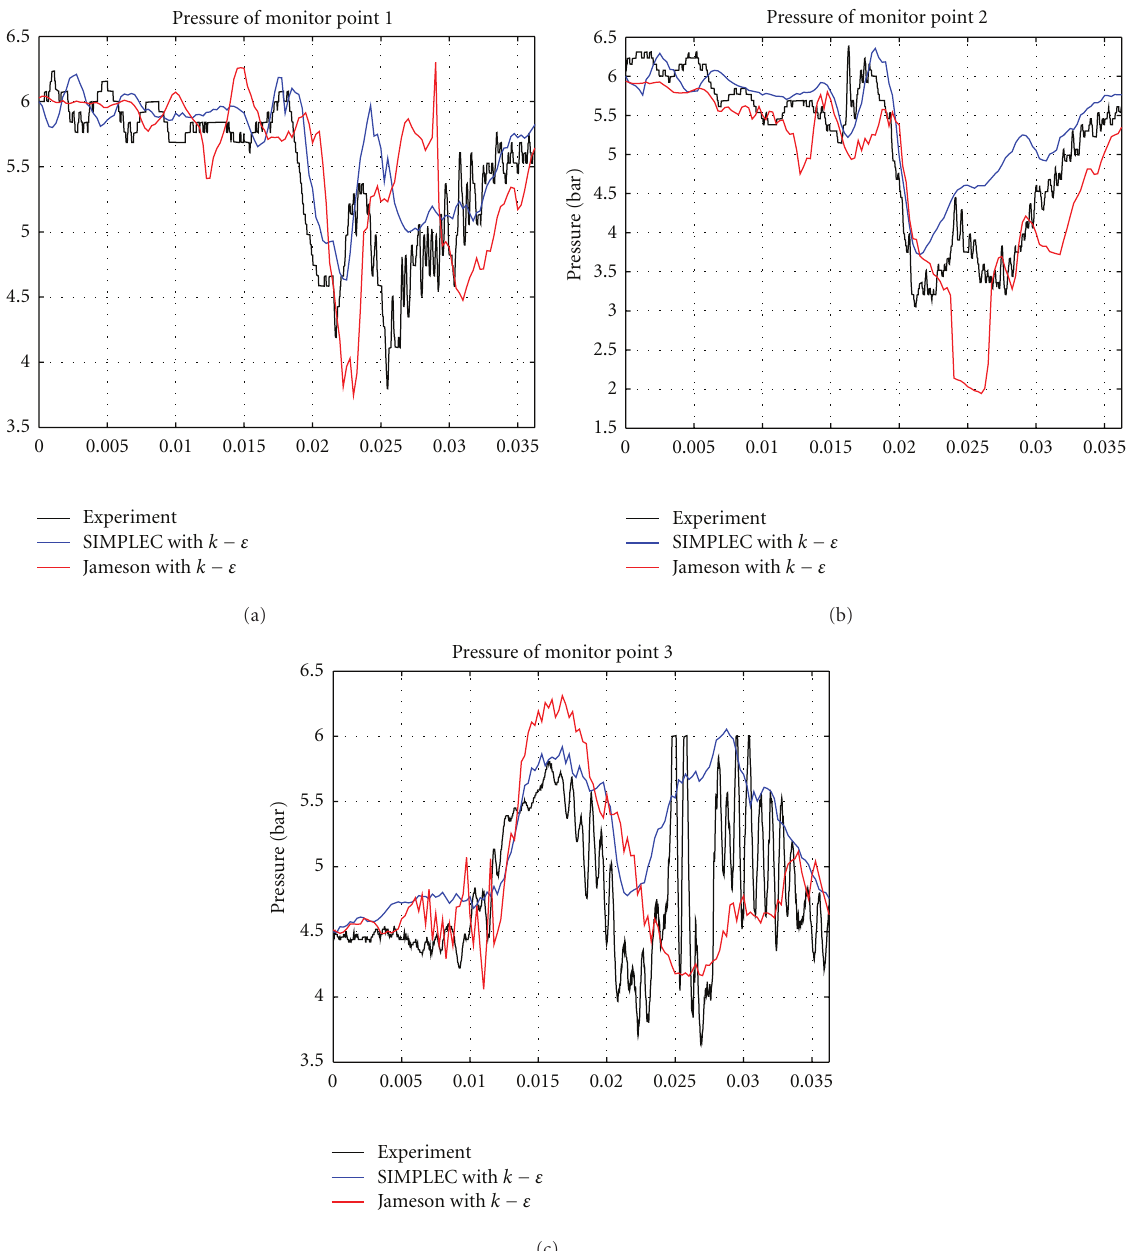
Figure 9: Comparison of measurement (black) with simulation with Jameson method (blue) and SIMPLEC (red) for three di ff erent monitor